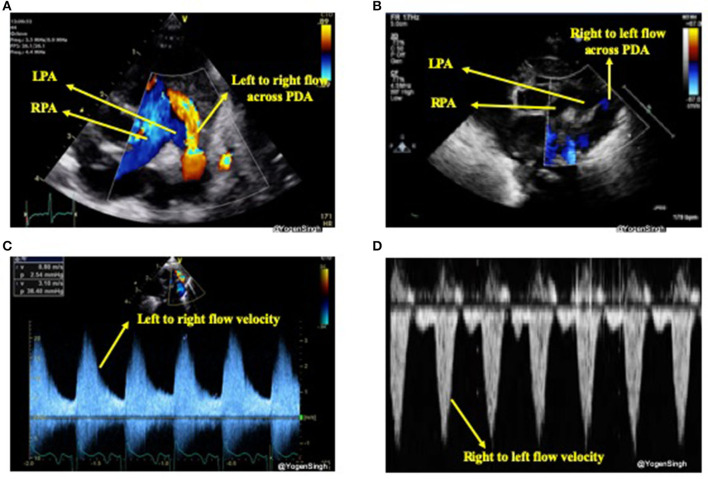
Assessment of PDA shunt direction on color flow and with Doppler application. (A) Left to right shunt seen as red (blood coming toward probe) while blood in branch pulmonary arteries seen as blue (blood going away from probe); (B) showing right to left shunt seen as blue color—similar to branch pulmonary arteries in a view “three legged trouser;” (C) Doppler assessment showing left to right shunt (above the baseline as blood coming toward the probe); and (D) Doppler assessment showing right to left shunt (below the baseline as blood going away from the probe). LPA, left pulmonary artery; RPA, right pulmonary artery; PDA, patent ductus arteriosus.